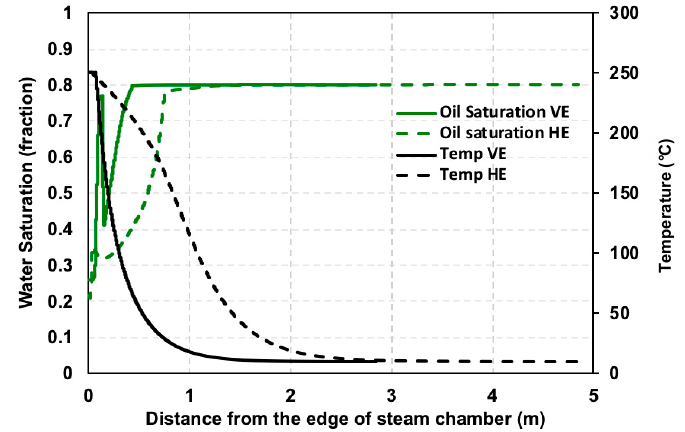
Figure 6. Water saturation profiles versus distance for the VE and HE models.